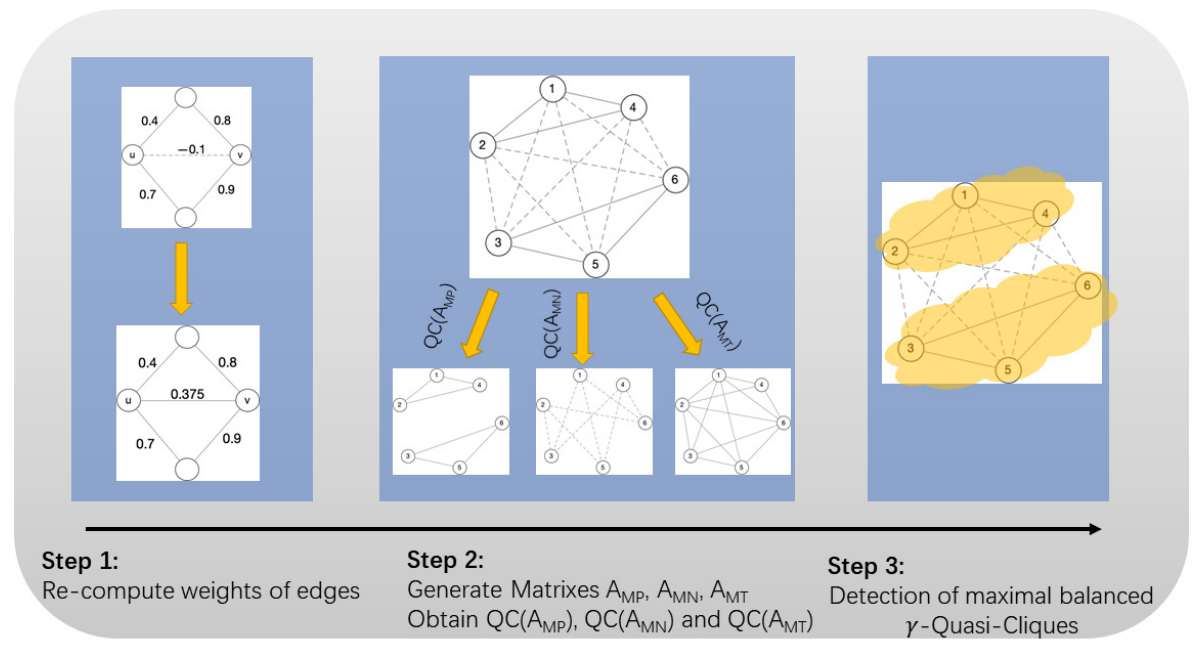
Figure 5. The overview of our